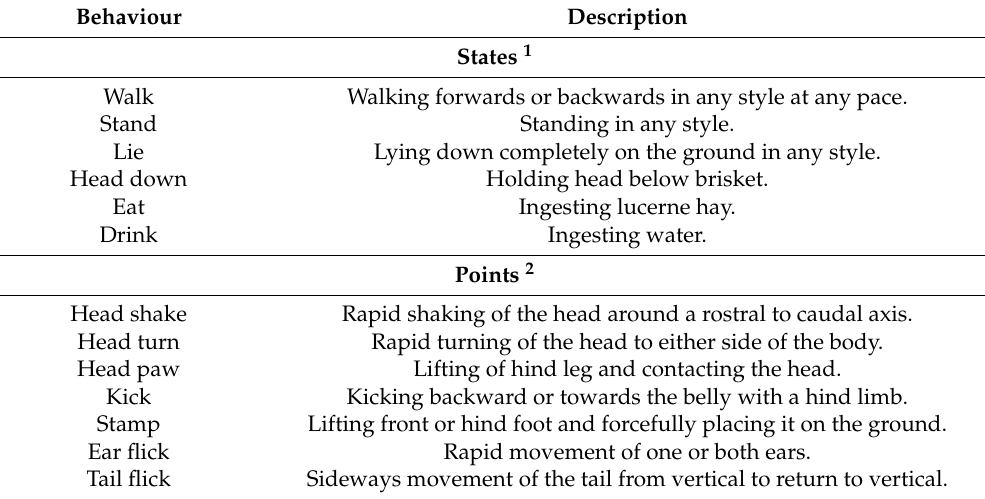
Table 1. Ethogram developed for behavioural observations conducted on calves following treatment. Behaviour